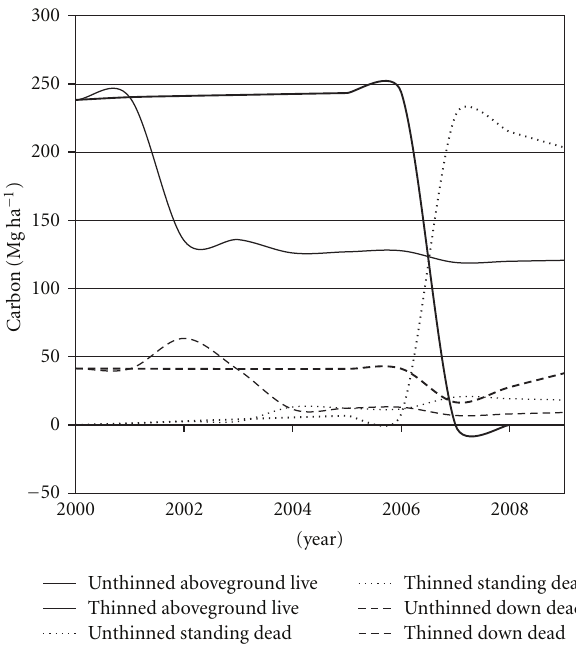
Figure 7: ArcFuels-generated graph of fuel treatment and wildfire impacts on selected carbon pools generated with FVS-FFE simu- lation and ArcFuels scripts for stand 1020 in the Mt. Emily study area. The graph was generated with the process as described in Figure 3, where users can model stand dynamics within ArcMap while viewing remotely sensed imagery such as digital orthophotos. The simulation included thinning (2002), underburning (2003), fuel removal (2004), and wildfire (2005).